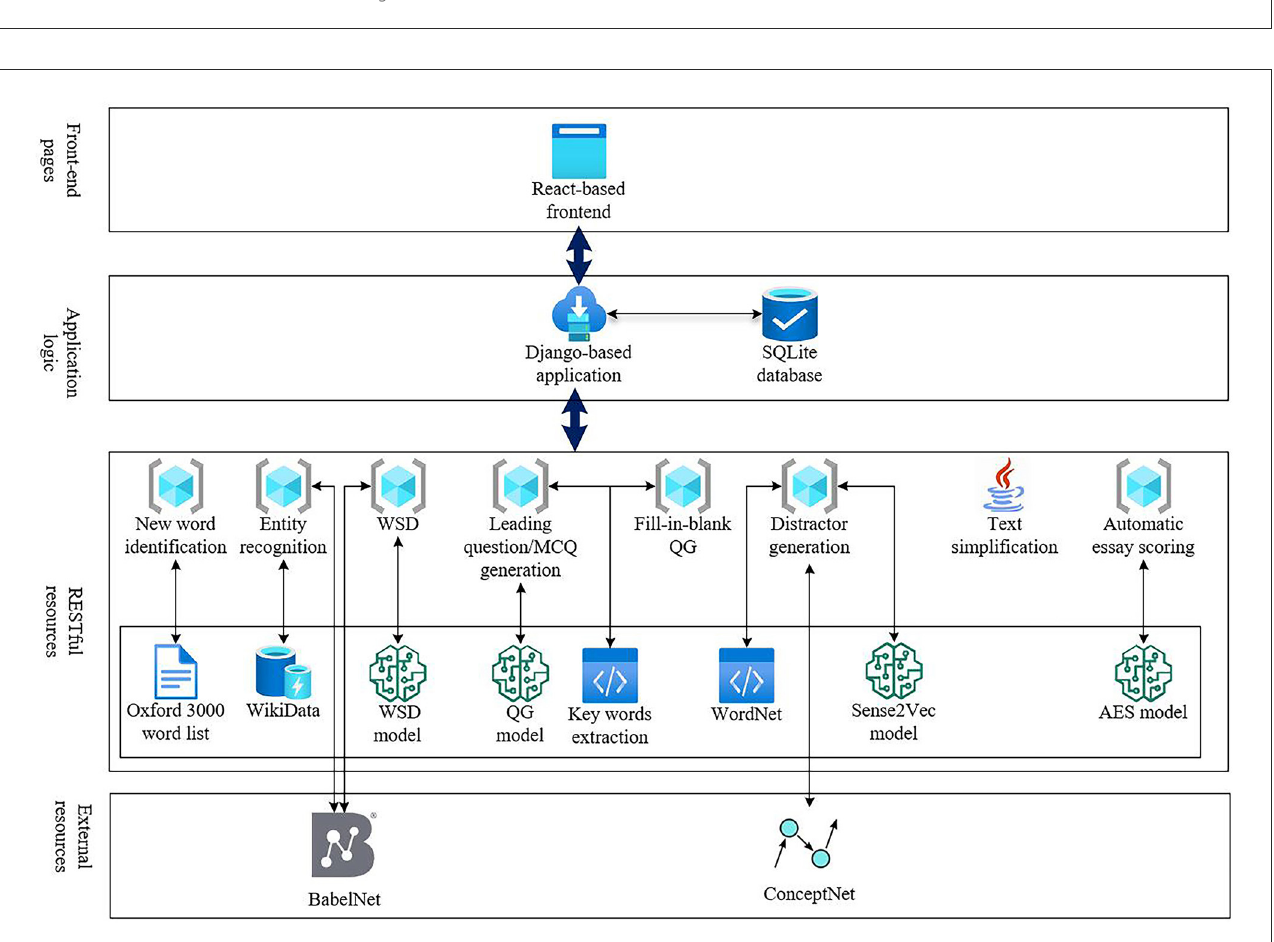
FIGURE6 Architecture of the reading